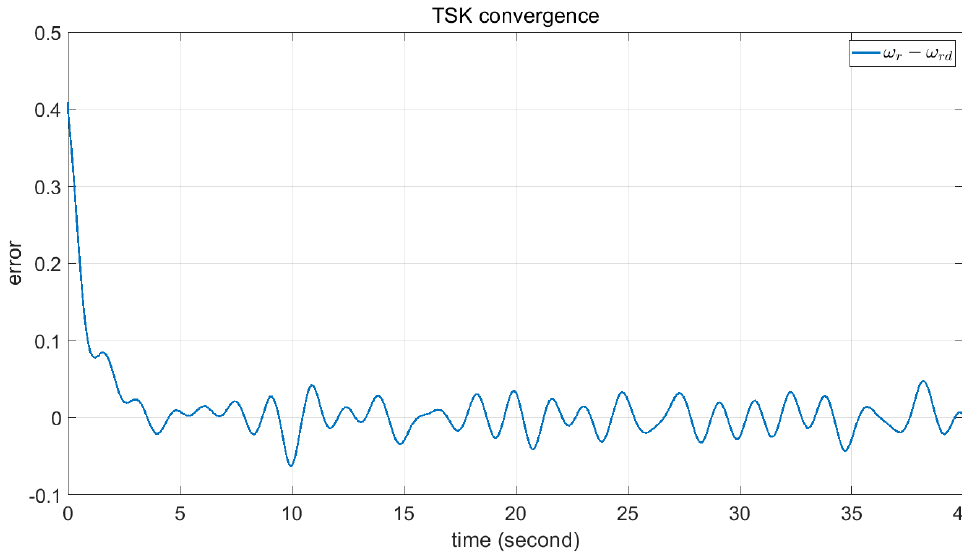
Figure 14. The angle of blades in FPSO.